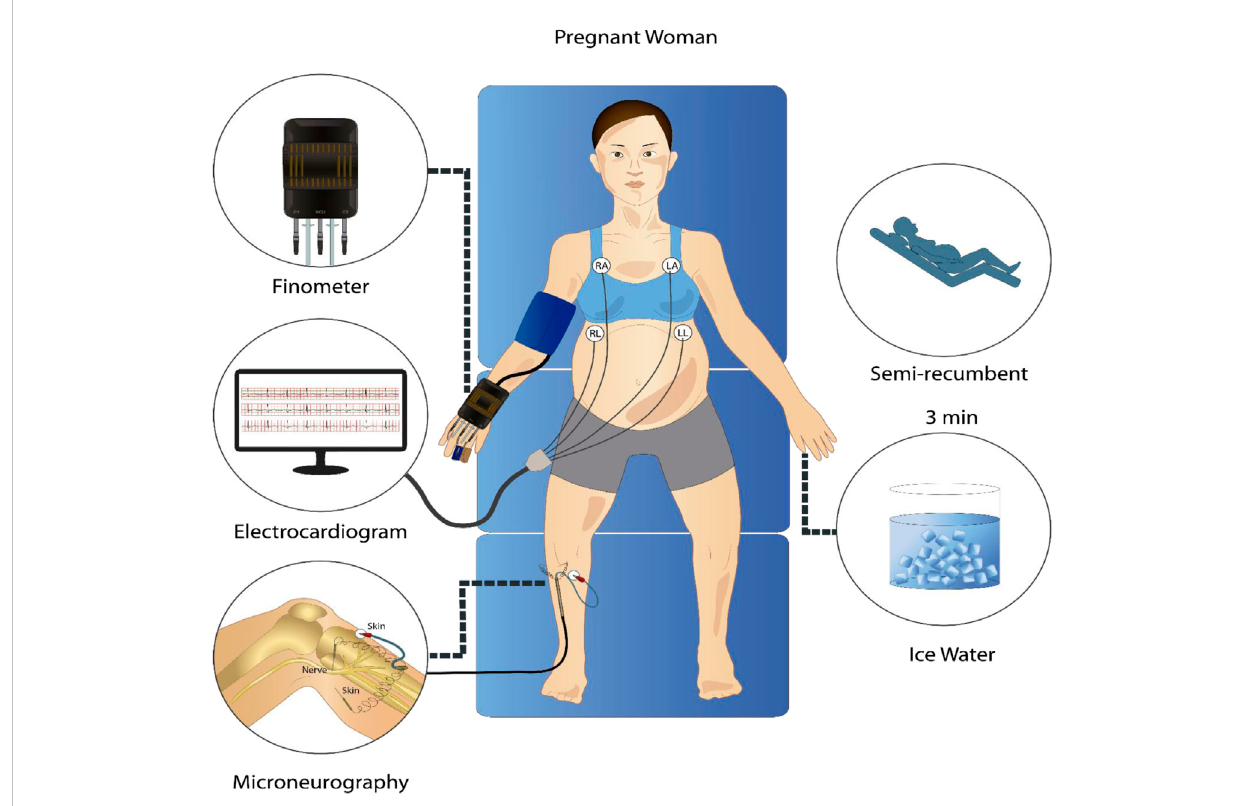
FIGURE 1 Representative schematic of the signal acquisition protocol. In a semi-recumbent position, participants underwent a 3-min rest period and a 3-min cold pressor test while electrocardiogram, continuous non-invasive blood pressure, and microneurography signals were recorded.